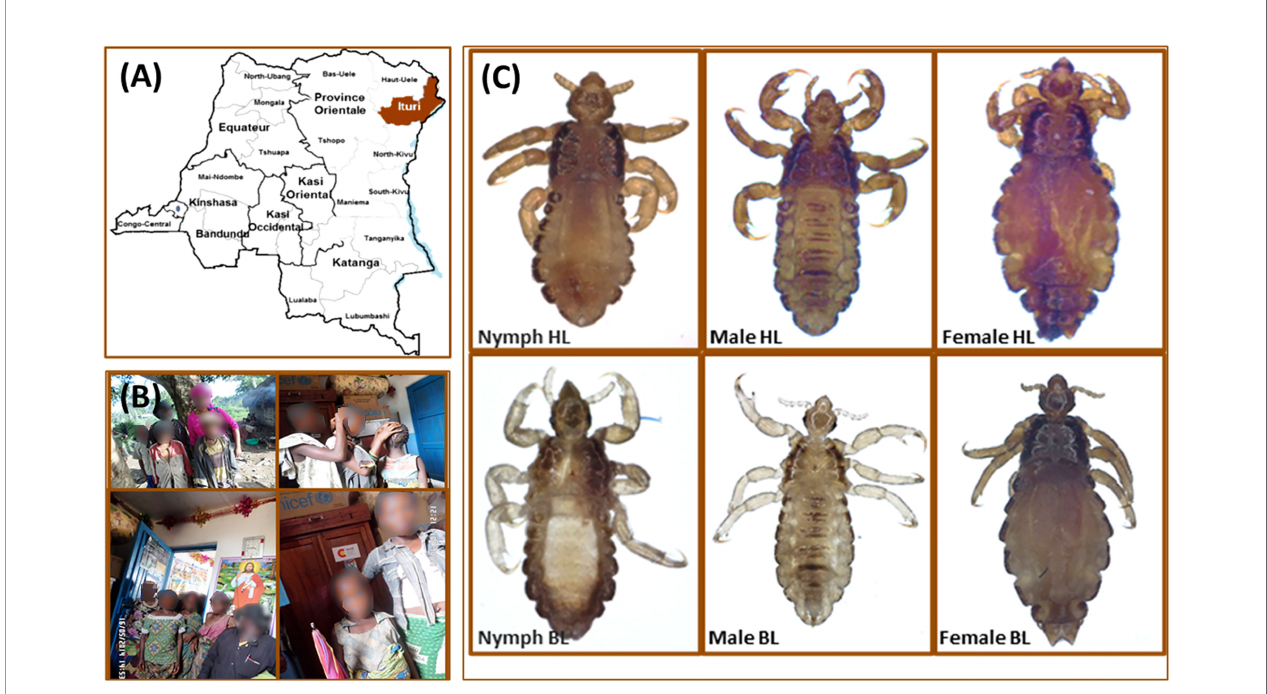
FIGURE 2 | Head and body lice collected from Mbuti pygmies, living in the Orientale province of the Democratic Republic of the Congo. (A) Geographical location of louse sampling. (B) Mbuti pygmies infested with lice. (C) Head and body lice from Mbuti